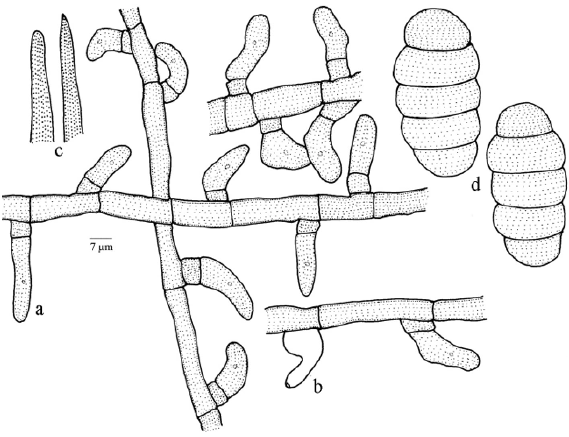
Figure 119. Meliola syzygiigena a - Appressorium; b - Phialide; c - Apical portion of mycelial setae; d -